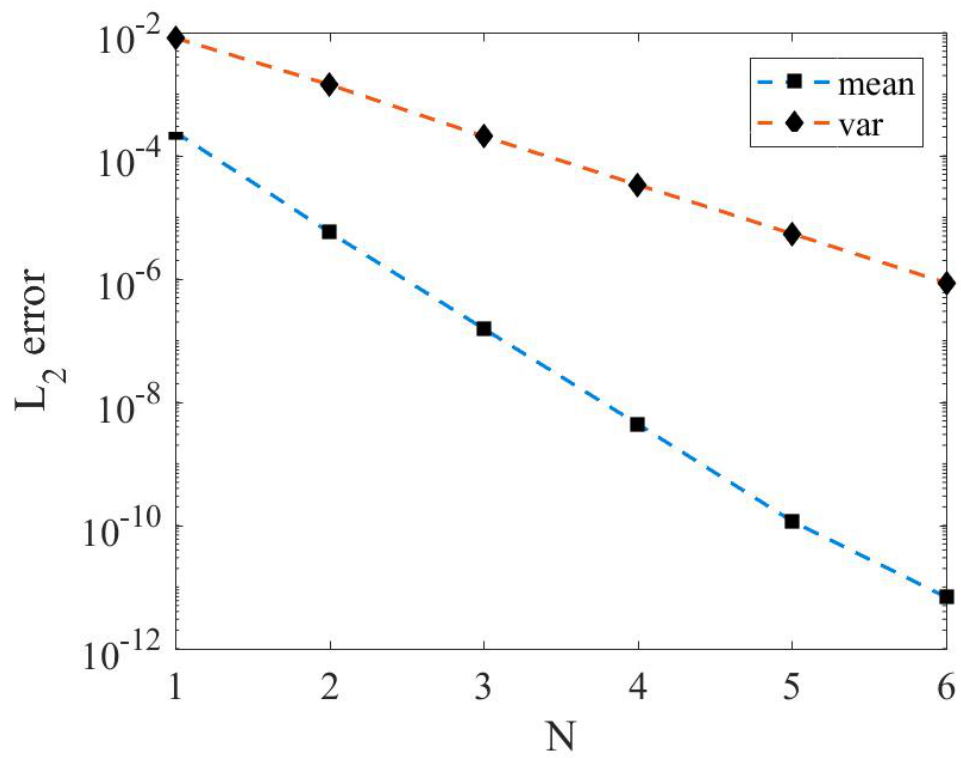
Figure 3. Mean (below) and variance (above) L 2 errors at t f =3 . The switching time t s =1 with different numbers of modes N .